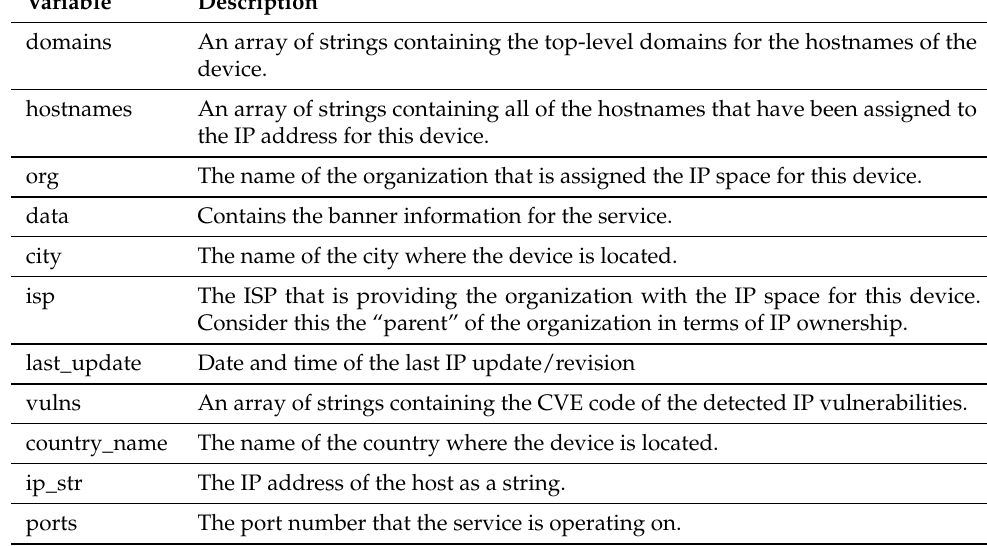
Table 1. Variables of Shodan Banner Specification.